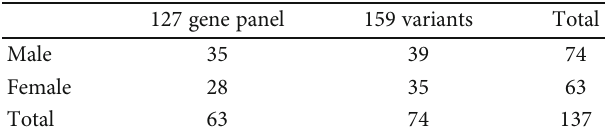
Table 1: The basic information of patients recruited in this research.